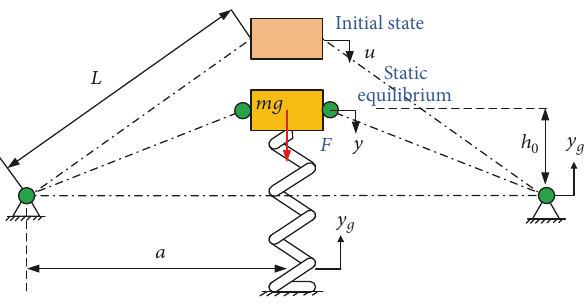
Figure 6: The dynamic analysis model of a QZS isolator at a static equilibrium